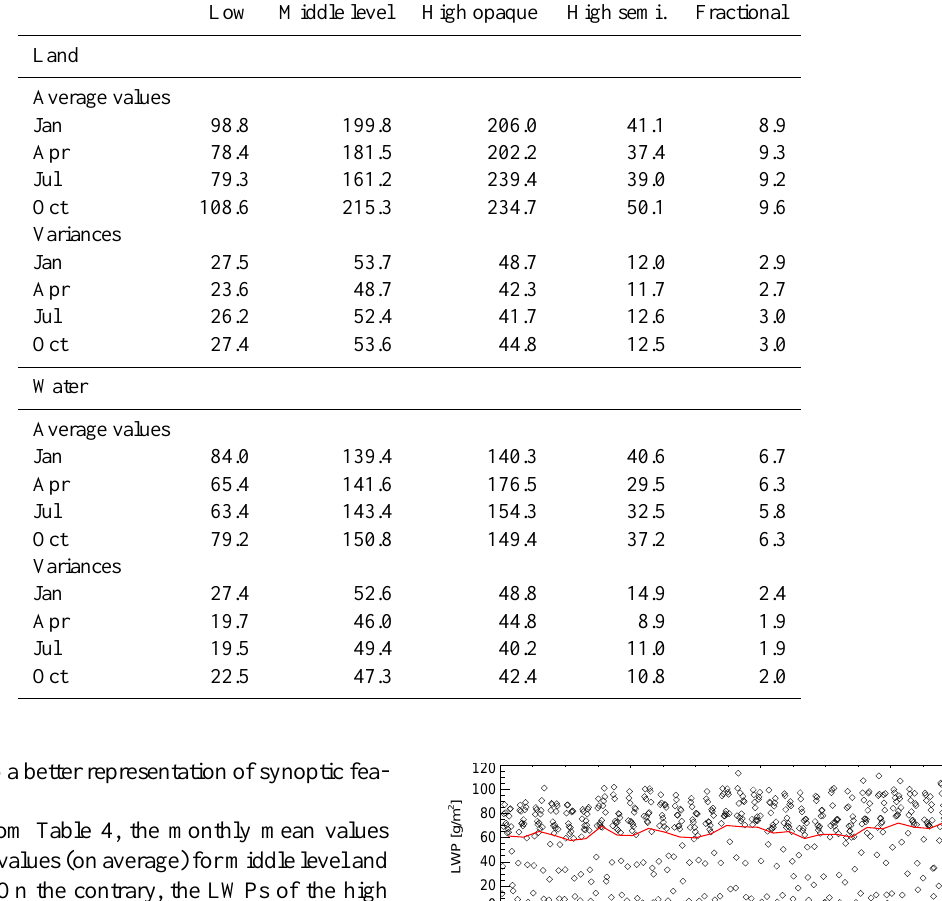
Table 3. Average LWP (gm − 2 ) for land and water pixels on the SEVIRI disc for January, April, July and October 2009, only filled pixels were averaged. Low Middle level High opaque High semi. Fractional